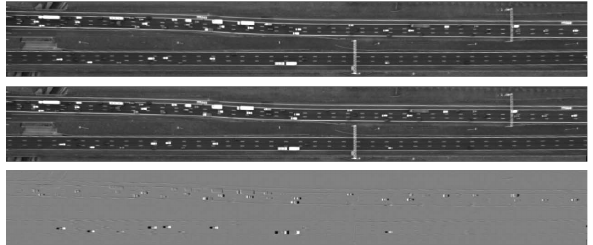
Figure 1: The difference image (bottom) is obtained by subtract- ing the middle from the top image. The top and middle images are consecutive.